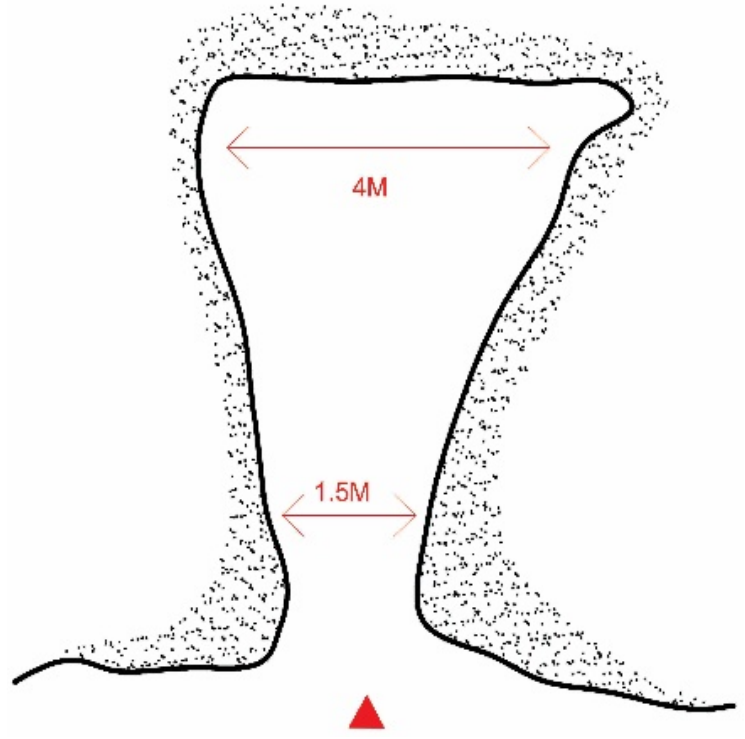
Figure 29. Triangular shape of the rock-cut architecture of Meymand.